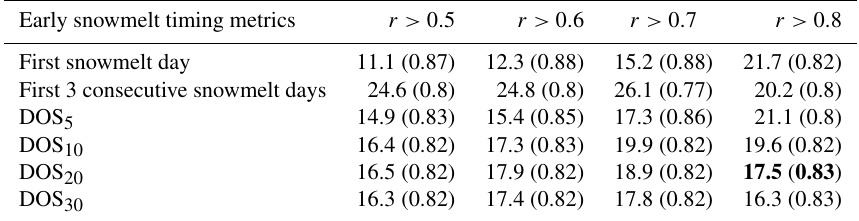
Table A2. Root mean square error (RMSE) and coefficient of determination ( R 2 ; in parentheses) associated with several stepwise multiple linear regressions (similar to the one in Eq. 1) using different early snowmelt timing metrics (e.g., Eq. 1 uses DOS 20 ) and correlation cutoffs ( r ) between hourly solar radiation and streamflow used to define snowmelt days. DOS xx represents the date when the xx th percentile of snowmelt days occurs. Bolded numbers are associated with the stepwise MLR in Eq. (1), which is also shown in Fig.